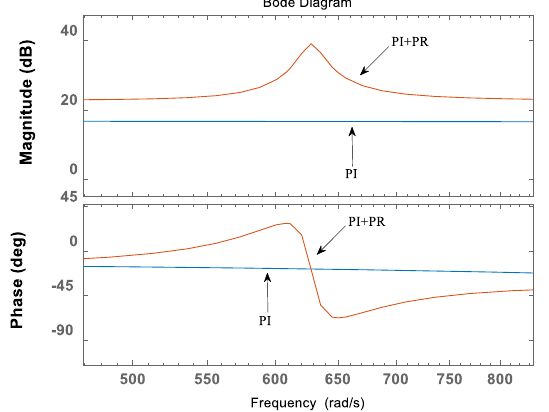
Figure 13. Frequency characteristics of double closed-loop control.